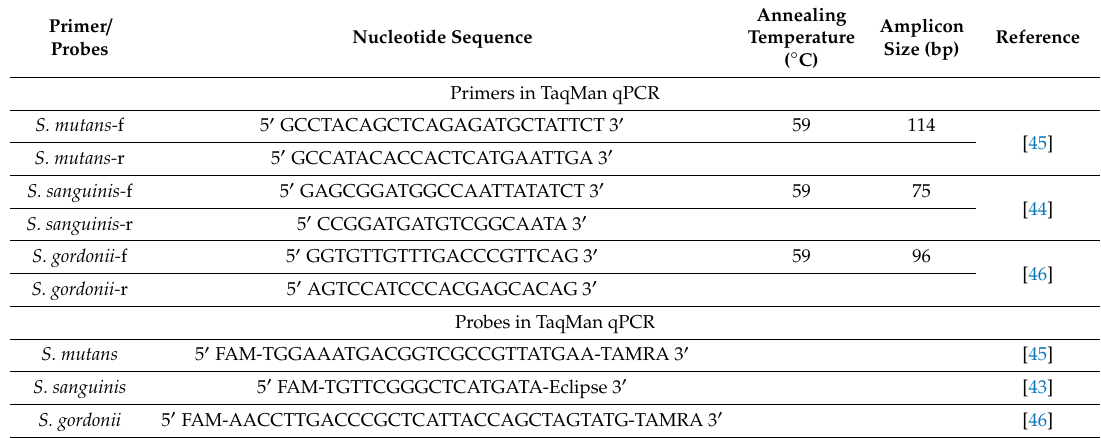
Table 2. Primers and probes used in TaqMan qPCR.